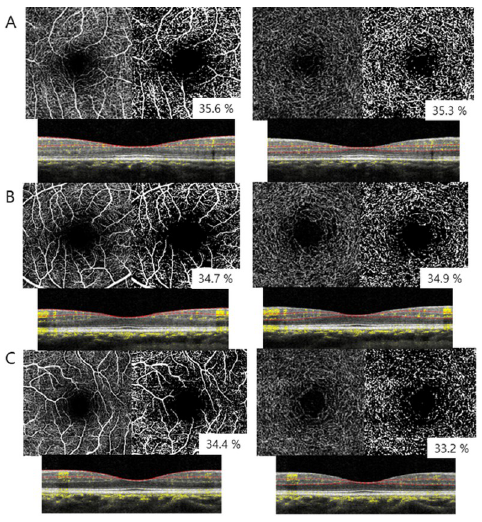
Fig 1. Representative original optical coherence tomography angiography images, images after conversion by ImageJ, and B-scan images of superficial capillary plexus and deep capillary plexus in control (A), DM group 1 (B), and DM group 2 (C).